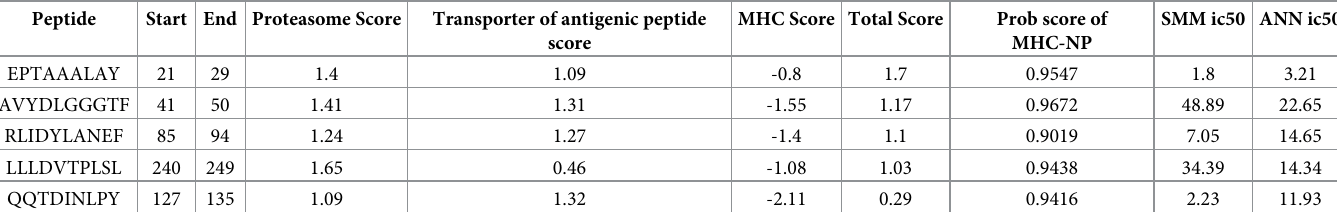
Table 3. Prediction of conserved peptides of antigen for processing and binding to MHC class I of T-cell epitopes.